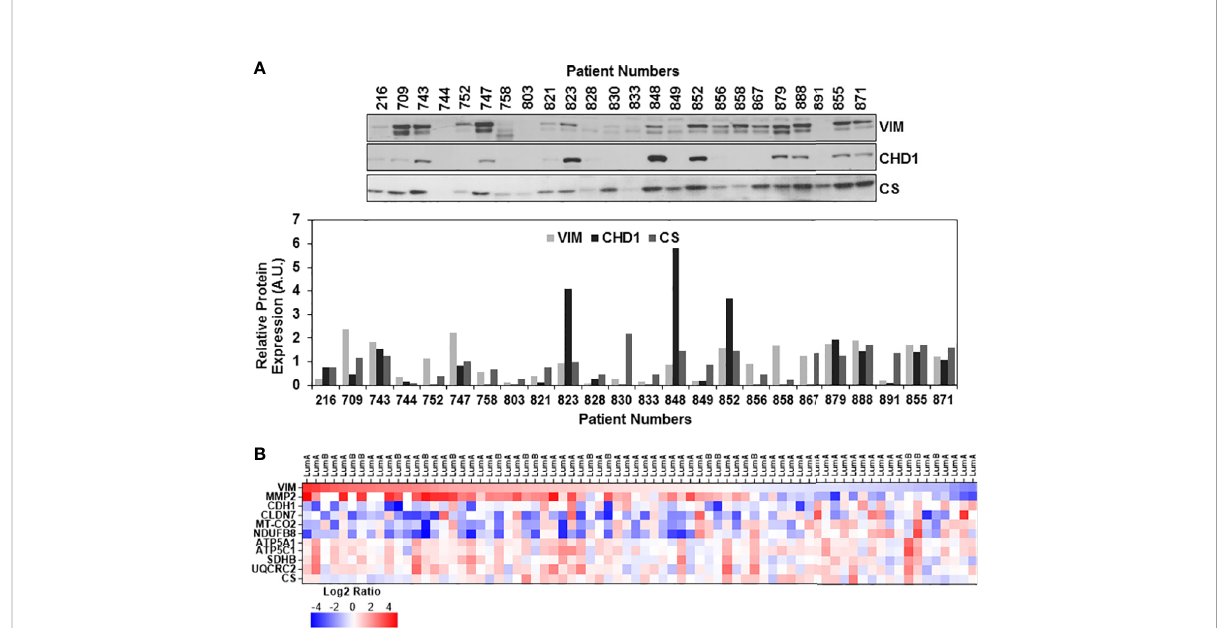
FIGURE 3 Expression of epithelial-mesenchymal transition markers in ER/PR(+) breast cancer. (A) Expressions of vimentin (VIM), E-cadherin (CHD1), and citrate synthase (CS) were detected by immunoblotting using 20 m g of patient biopsies as described in Figures 1A and 2A. Relative VIM, CHD1, and CS expressions were quanti fi ed by normalizing antibody signal intensities to protein loading. (B) Expression of VIM, metalloprotease-2 (MMP2), CHD1, and claudin-7 (CLDN7) was compared to MT-COII and NDUFB8 log2 expression ratios to demonstrate the changes in EMT and metastatic markers using the CPTAC data set (65) (see text for the discussion). VIM expression is ranked from high (red) to low (blue). Increased VIM and MMP2 expression in majority of the luminal A and B biopsies correspond to the decreased OXPHOS subunit expression (MT-COII and NDUFB8) and epithelial markers (CHD1 and